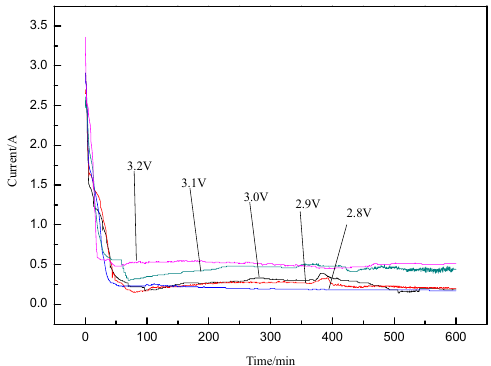
Figure 5. Current–time plots of electro-deoxidation oxide mixture at different voltage.